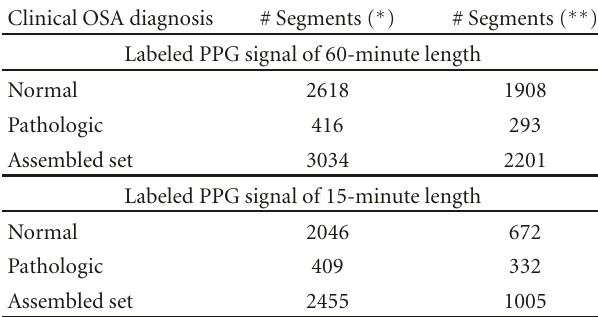
Table 1: Amount of 90-second partitions accomplished for both cases of labeled ppg signal